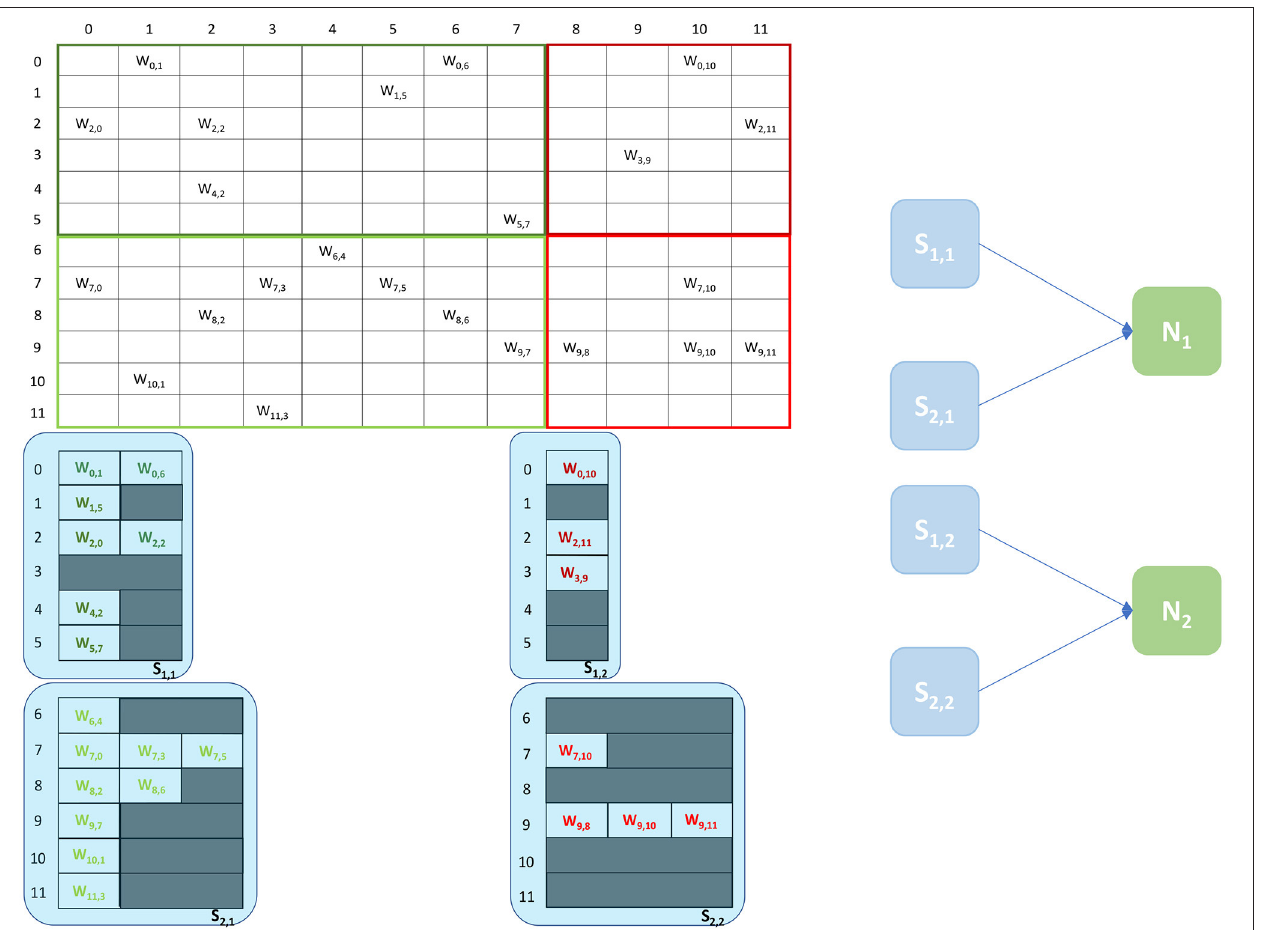
FIGURE 3 | Synaptic matrix partitioning under the Heterogeneous Programming Model. The same matrix presented in Figure 2 is used. Synapse cores allow to partition the matrix by presynaptic index, and to relieve Neuron cores from processing spikes, enabling the possibility of simulating more neurons per core, which in turn allows to increase the length of synaptic rows. A schematic of the ensembles generated by this partitioning is shown on the right, where each Neuron core receives inputs from two Synapse